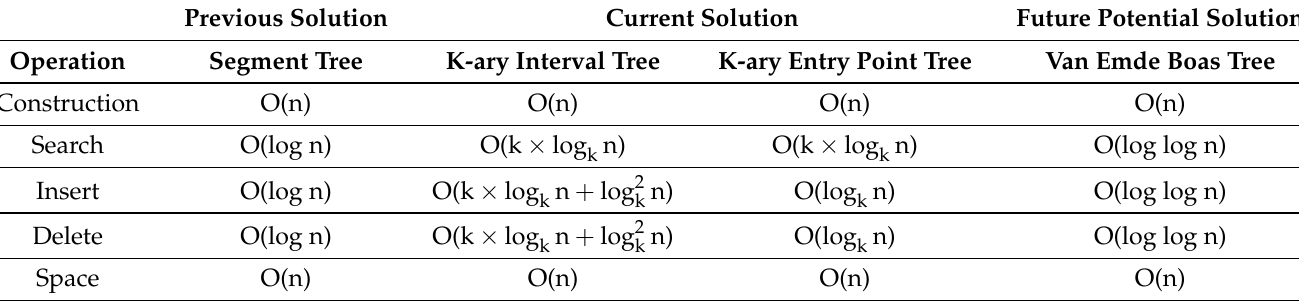
Table 2. Complexities of Range Query Data